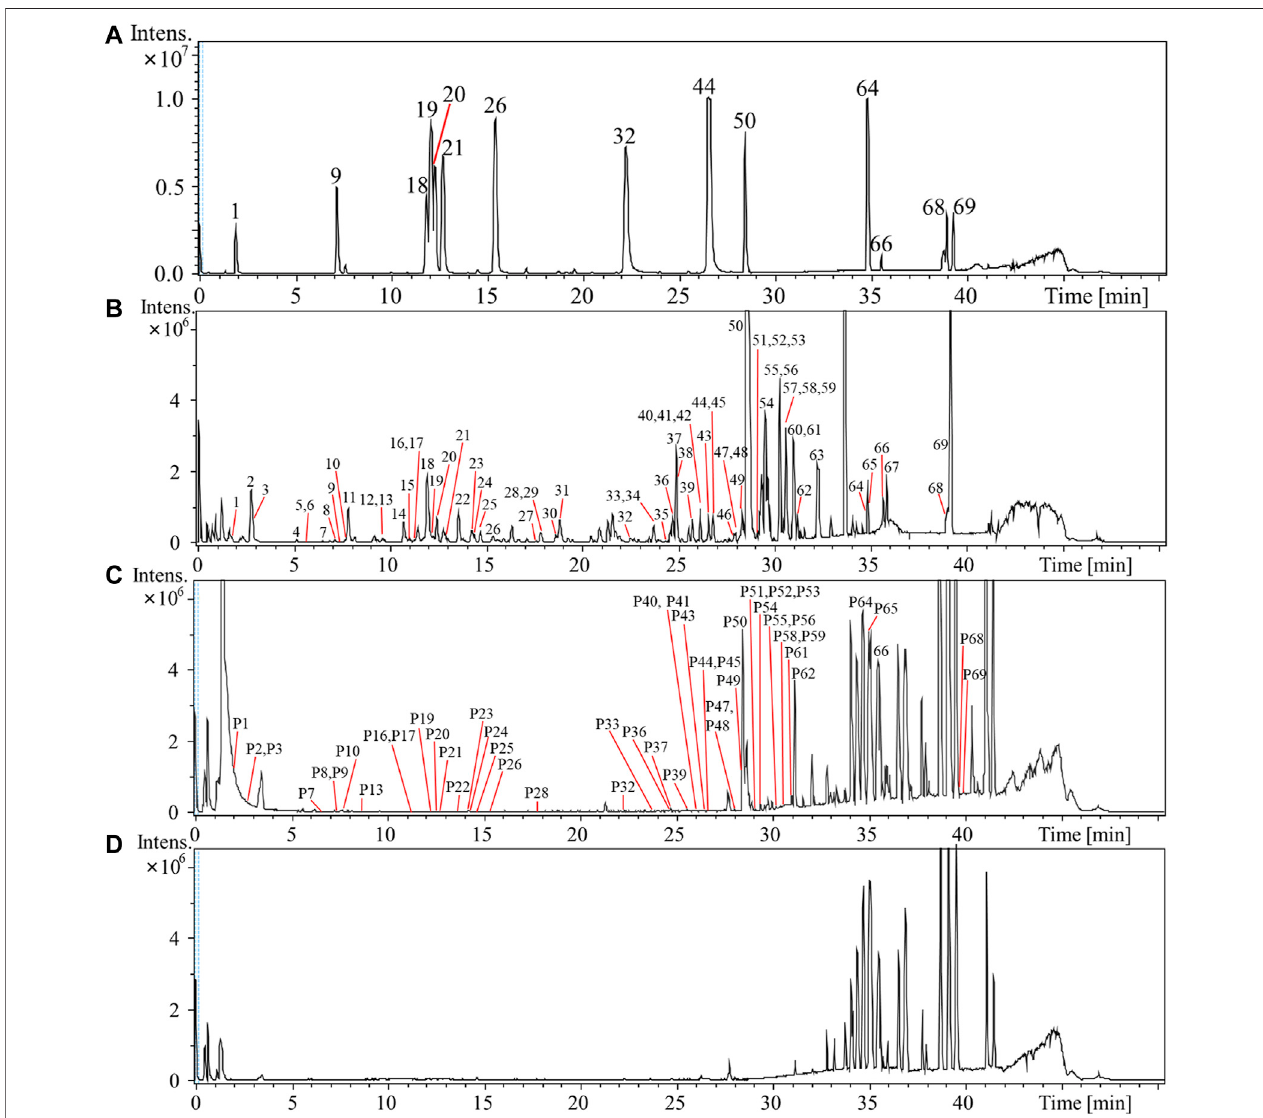
FIGURE1| Basepeak intensity(BPI) chromatogram ofmixedreferencecompounds (A) and60%ethanolextractsampleof Rubus chingii var. suavissimus (RS08) (B) , rat plasma sample (C) , and blank rat plasma (D) of rats in negative ion mode by UPLC-Q/TOF-MS.